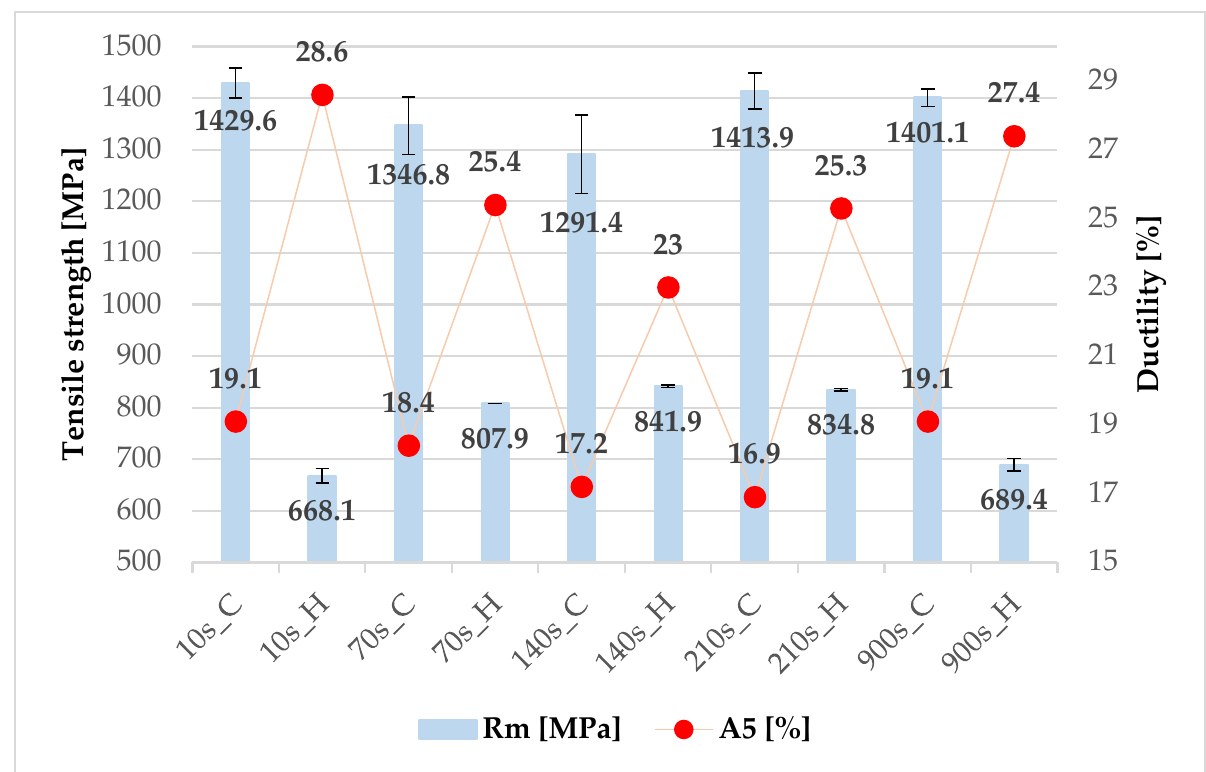
Figure 8. Position of mini tensile specimens on the omega profile product from cooled and heated part.